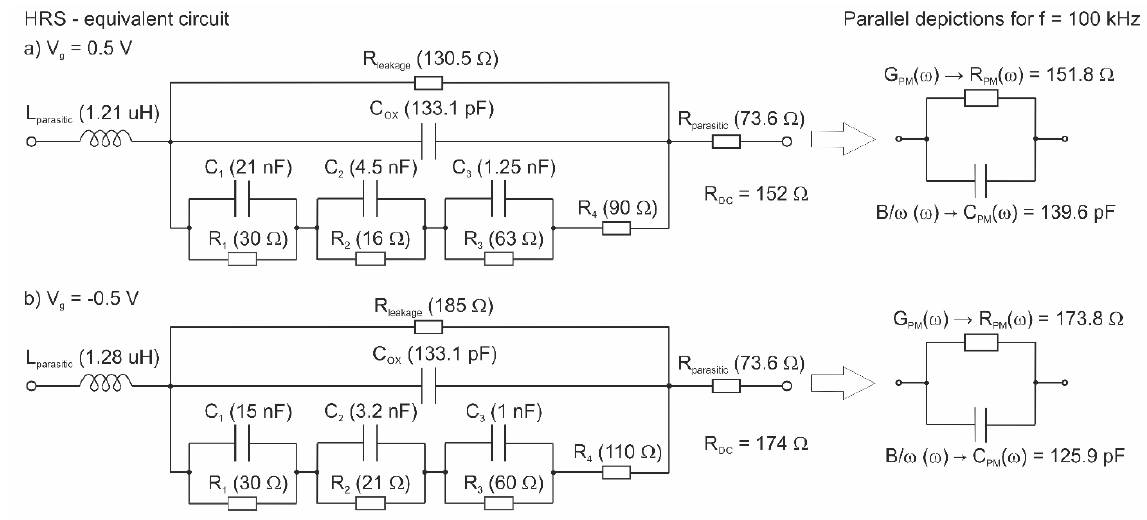
Figure 9. Electrical equivalent circuit for the measured device in HRS at two bias points, ( a ) V g = 0.5 V ( b ) V g = - 0.5 V.